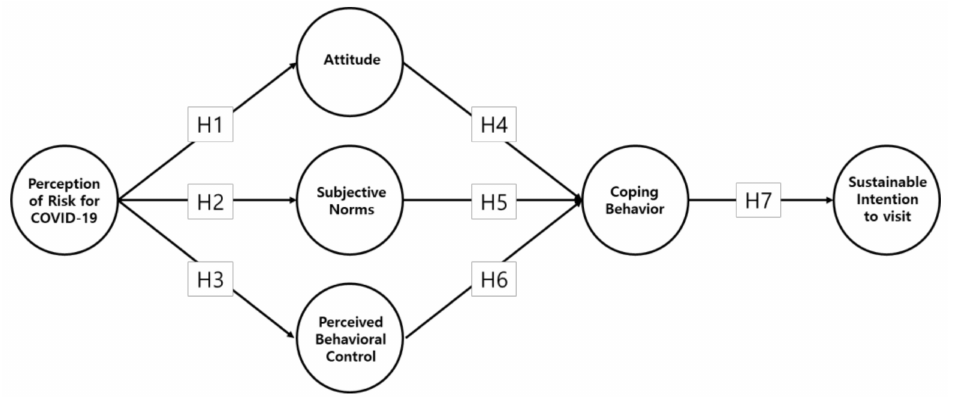
Figure 1. Research